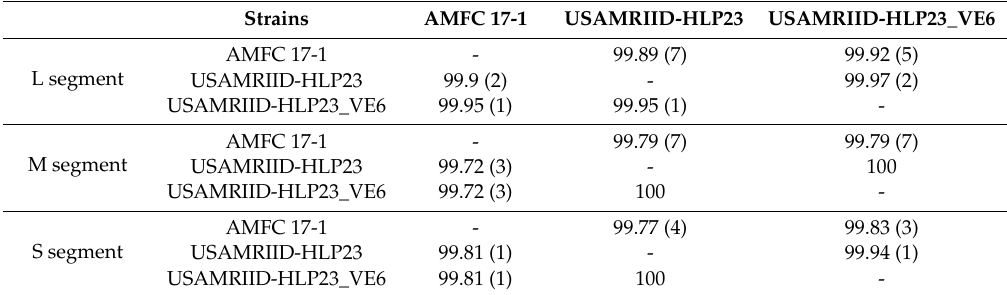
Table 3. Comparison of the complete genomic sequences of SFTSV detected in the SFTS case, the tick pool, and the Vero E6 isolate, showing a high level of both nucleotide and amino-acid homology. Data are presented as a percentage-of-identity matrices, with the number of changes indicated between parentheses, elaborated with either nucleotide (upper right half) or amino acid (lower left half) sequence alignments of full L, M, and S genomic